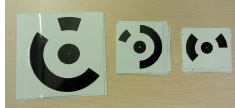
Figure 4: Customized target stickers with different target sizes.